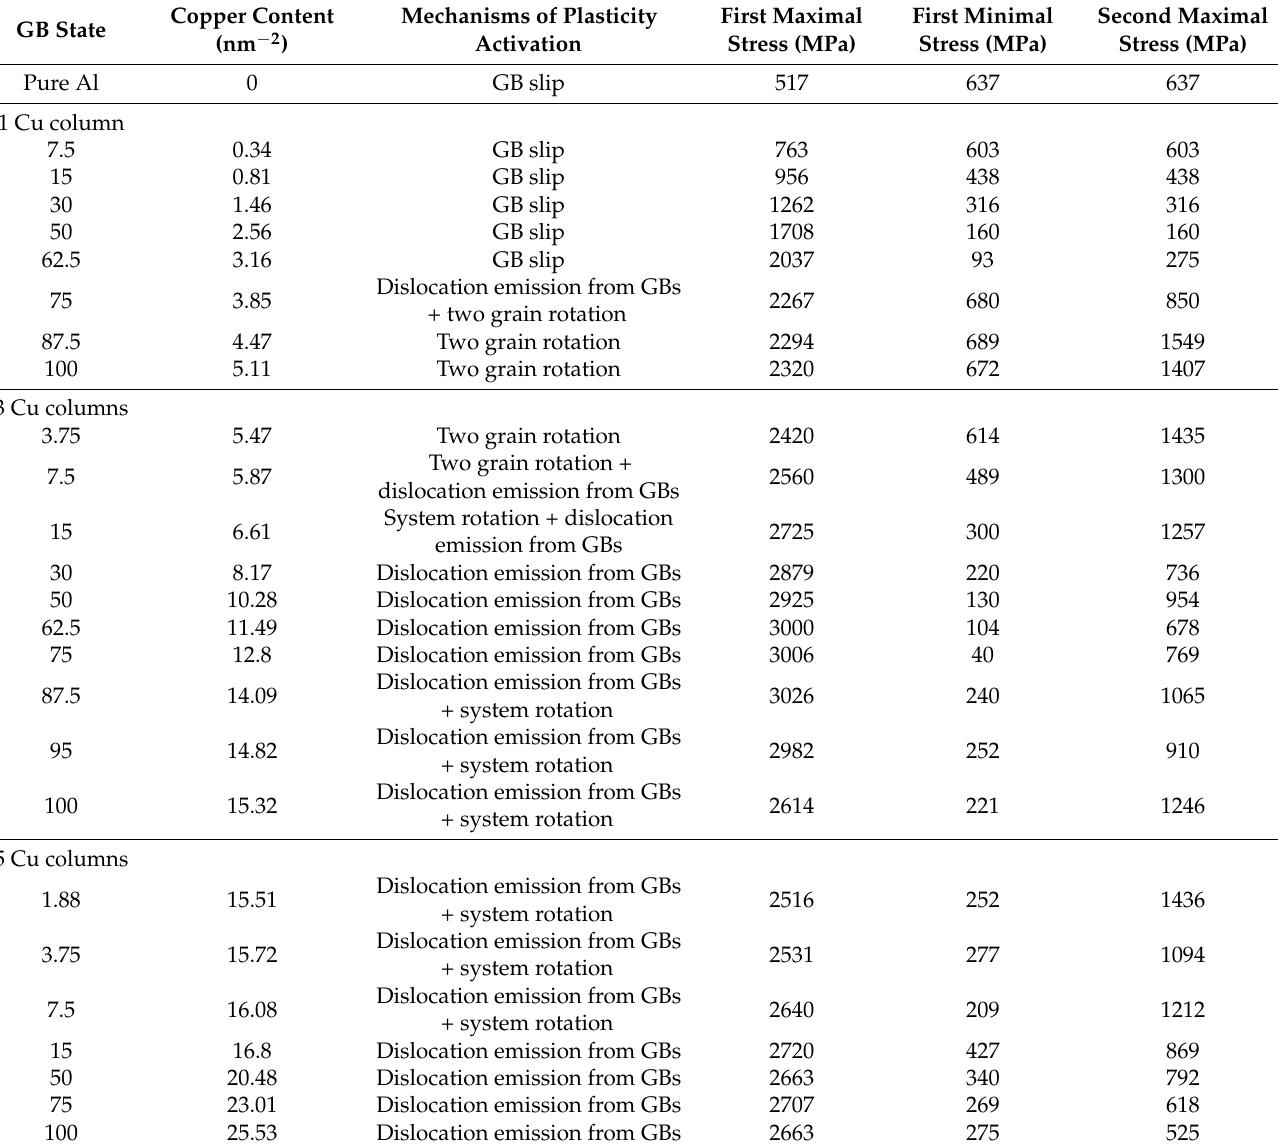
Table 1. Mechanisms of plastic relaxation and characteristic stresses for systems with different Cu